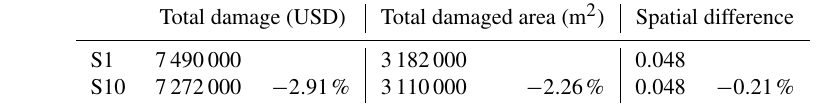
Table 7. Calculated total damage, total damaged area and spatial difference for S10 in comparison to S1.